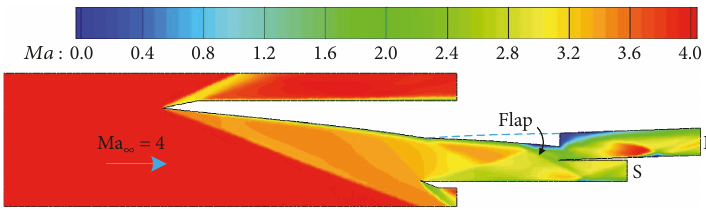
= 4 with an intermediate state where the fl ap rotates to the middle of the ejector fl ow ∞